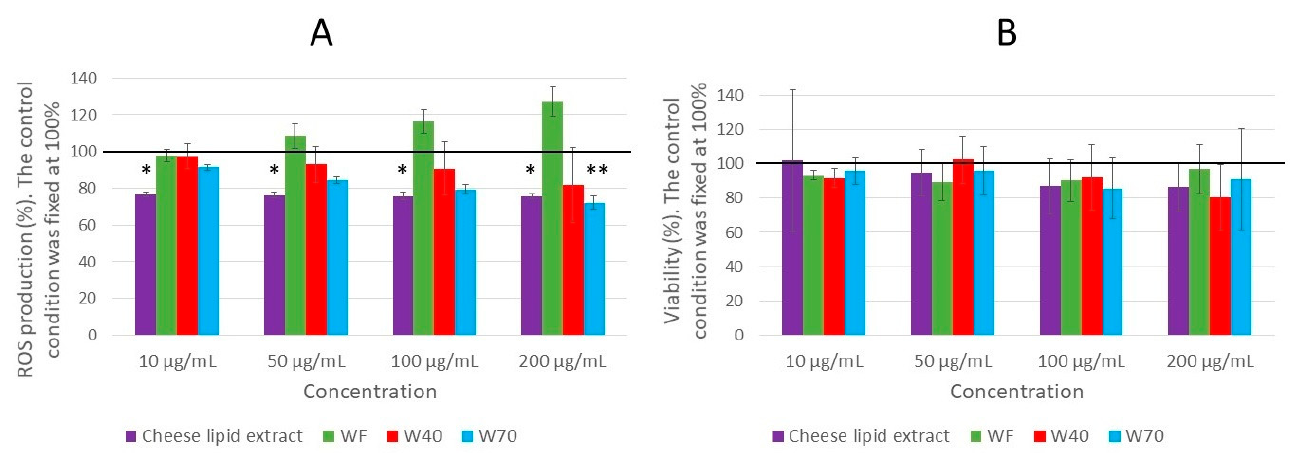
Figure 9. The effect of the cheese-lipid extract, WF, W40 and W70 on the ROS production in the leukocytes ( A ) and the viability of the leukocytes ( B ). The cells were treated with the indicated concentrations of the extract for 2 h, and measurements were made every 30 min. Data were expressed as relative production or viability in comparison with the control which was fixed at 100%. The conditions were considered significantly different from the control when the p -value was lower than 0.05 (*), 0.01 (**) (Kruskal–Wallis test).